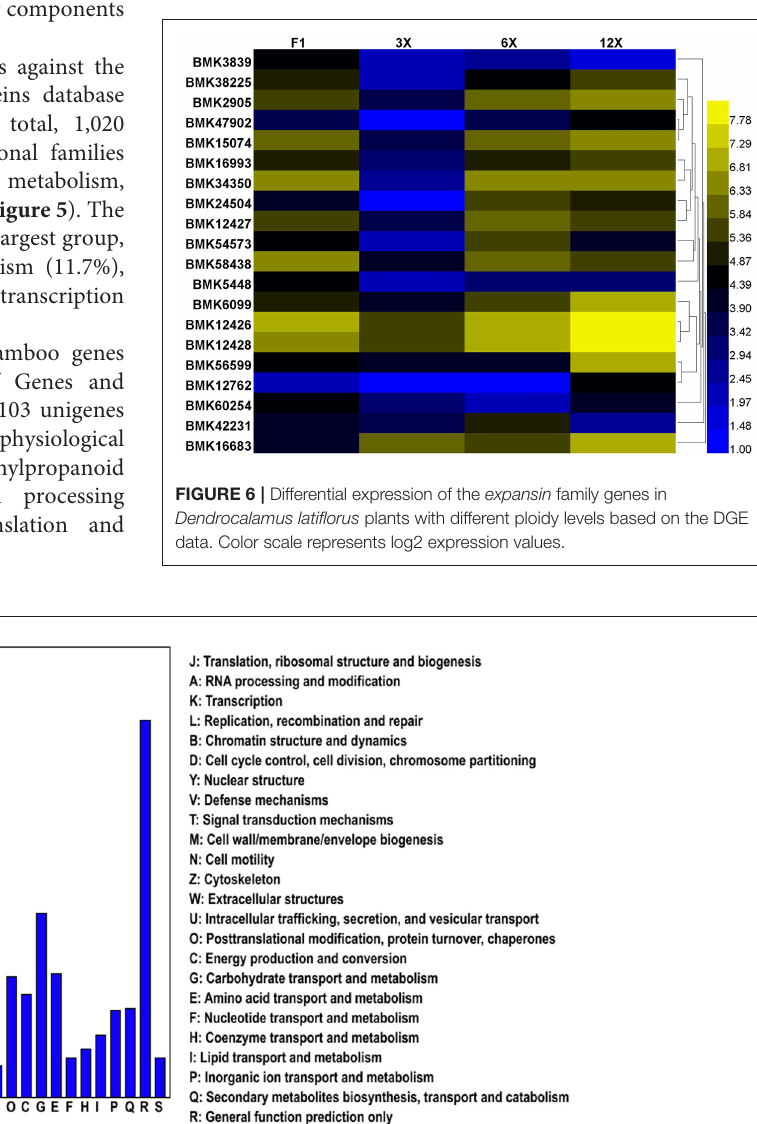
Frontiers in Plant Science |